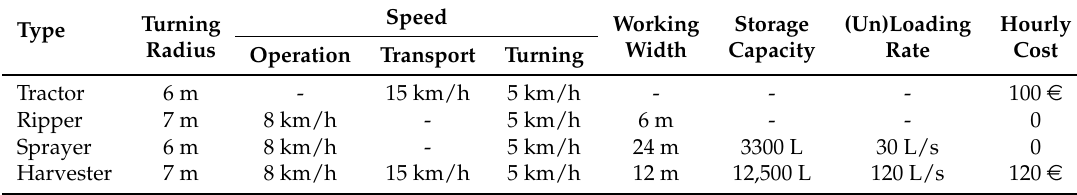
Table 1. Equipment parameters used for the results presented in this paper.